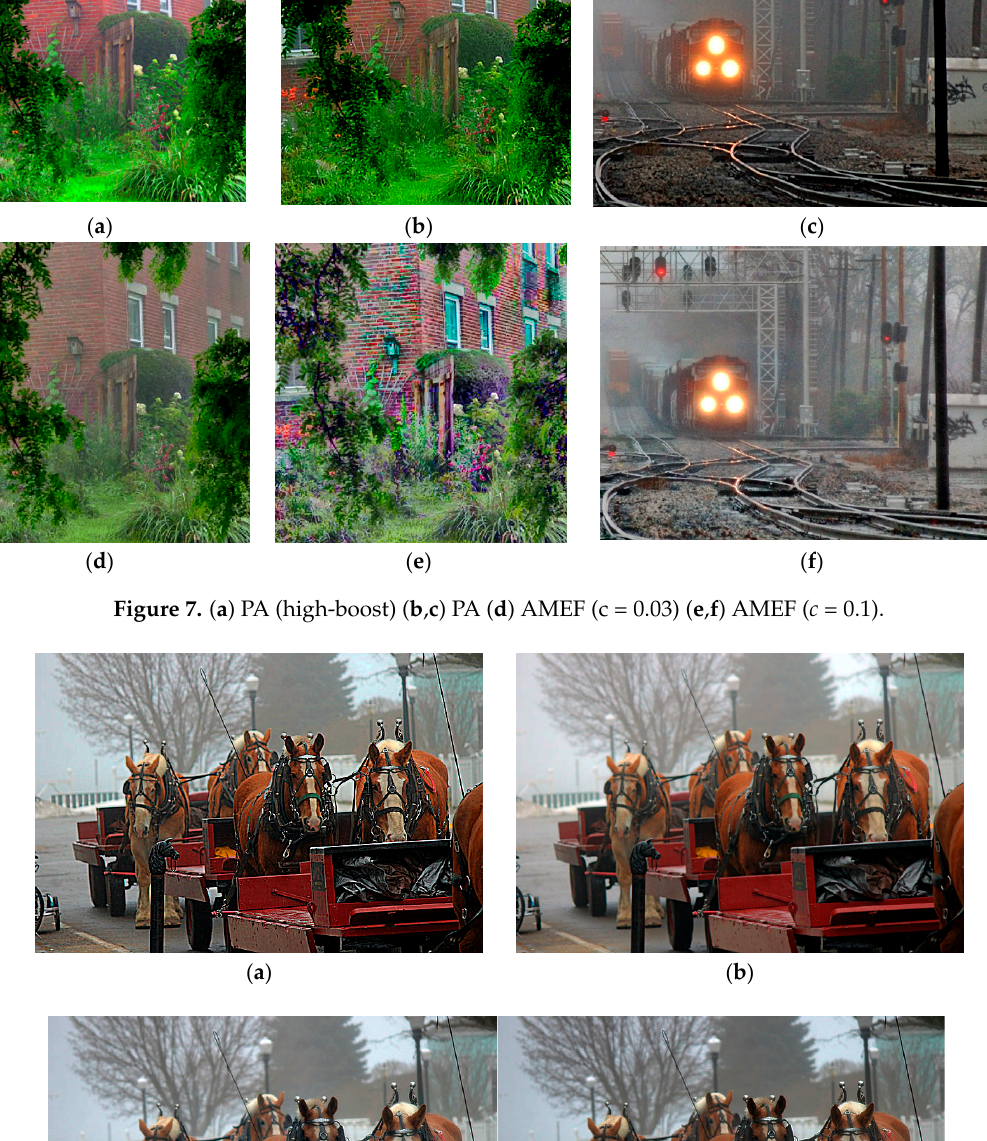
Figure 6. ( a ) PA, ( b ) without GOCS, ( c ) using high-boost filter setting, ( d ) AMEF ( c = 0.1), ( e ) AMEF ( c = 0.01), and ( f ) AMEF without CLAHE.